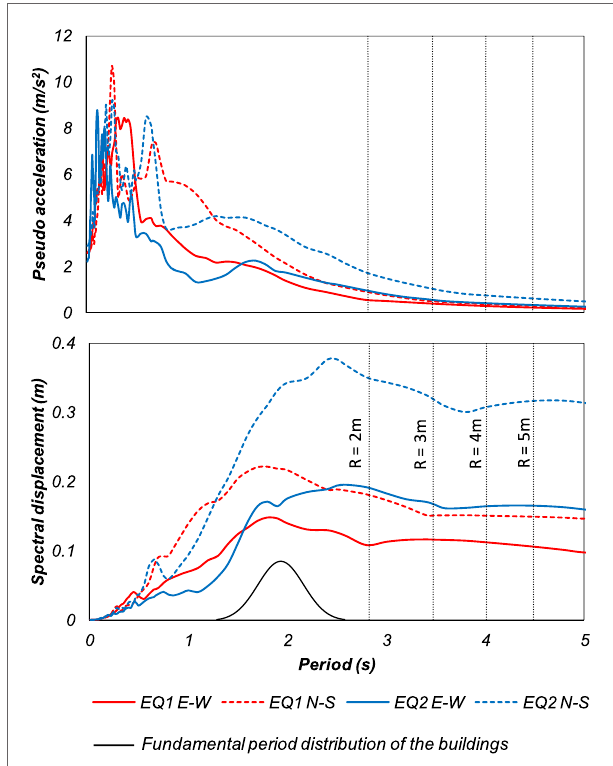
FigUre 7 | Elastic spectra of the considered earthquake components.